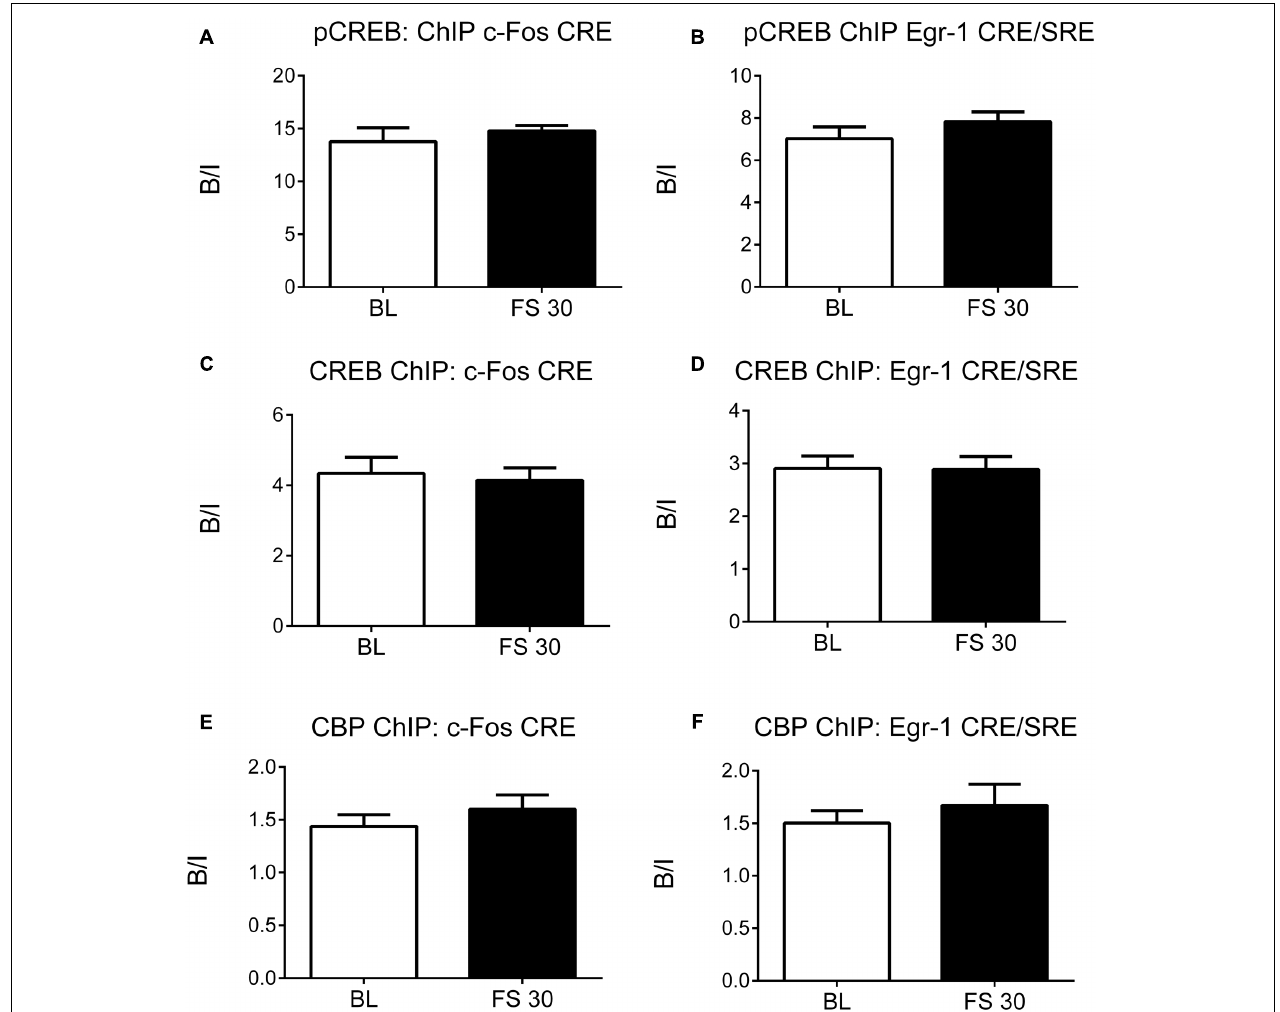
FIGURE 3 | pCREB, CREB, and CBP binding to the CREs in the promoter regions of c-Fos and Egr-1 . Rats were killed either under baseline conditions or 30 min after the start of FC (15 min in 25 ◦ C water). Chromatin immuno-precipitation was carried out on whole hippocampal tissue, using antibodies against pCREB, CREB and CBP. Primers for qPCR were designed to cover the CREs in the promoter regions of c-Fos and Egr-1 . The graphs show the enrichment of (A) pCREB at the c-Fos promoter CRE, (B) pCREB at the Egr-1 promoter CRE/SRE, (C) CREB at the c-Fos promoter CRE, (D) CREB at the Egr-1 promoter CRE/SRE, (E) CBP at the c-Fos promoter CRE, (F) CBP at the Egr-1 promoter CRE/SRE. The enrichment for each group was calculated by dividing the quantity of target DNA in the bound fraction by the quantity of DNA in the input fraction (ratio of bound over input, B/I) [mean ± SEM, n = 3–6 ( n = 6 in BL group)]. Statistical analysis: Student’s unpaired t -test; (A) t = 0.78, p = 0.4608, (B) t = 1.10, p = 0.3068, (C) t = 0.34, p = 0.7451, (D) t = 0.04, p = 0.9666, (E) t = 0.95, p = 0.3878, (F) t = 0.77, p =